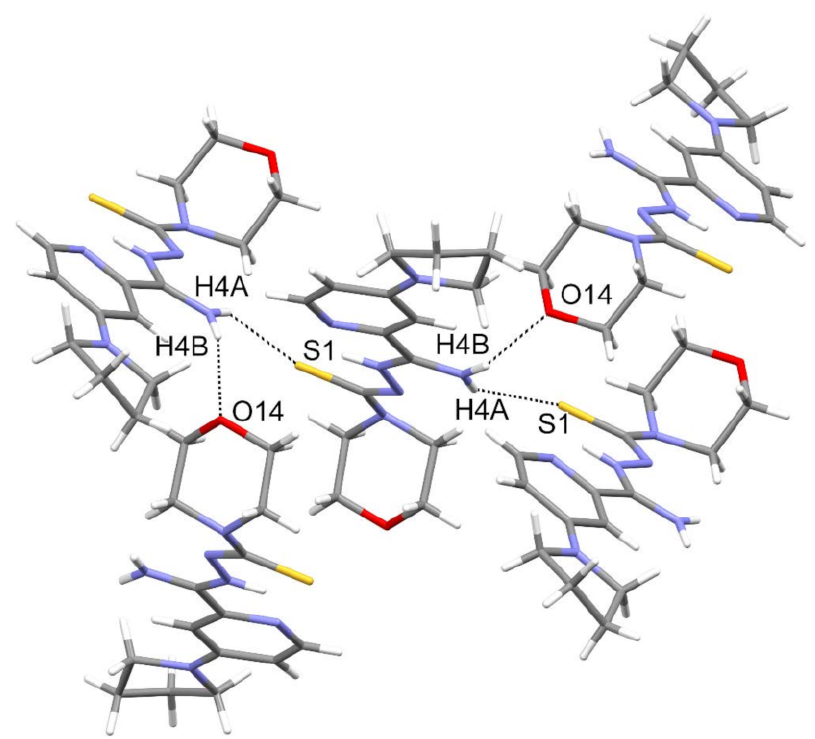
Figure 10. The intermolecular hydrogen bonds in compound 6 .